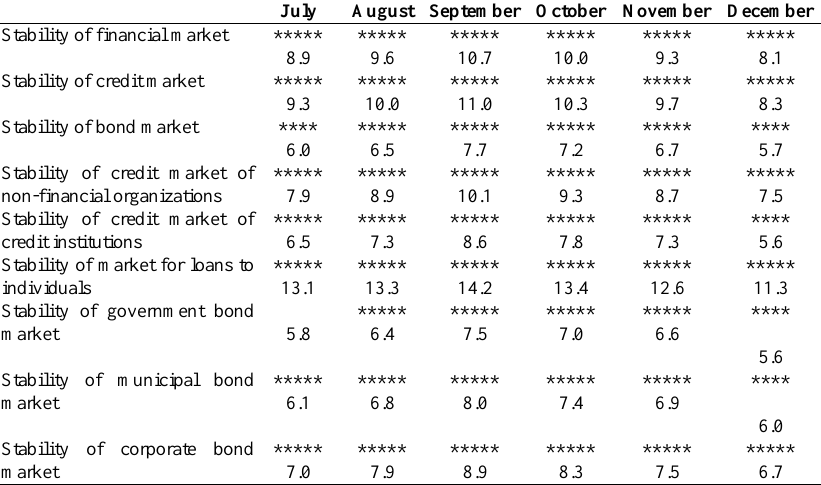
Table 9. Risk map of market financial stability for the second half of